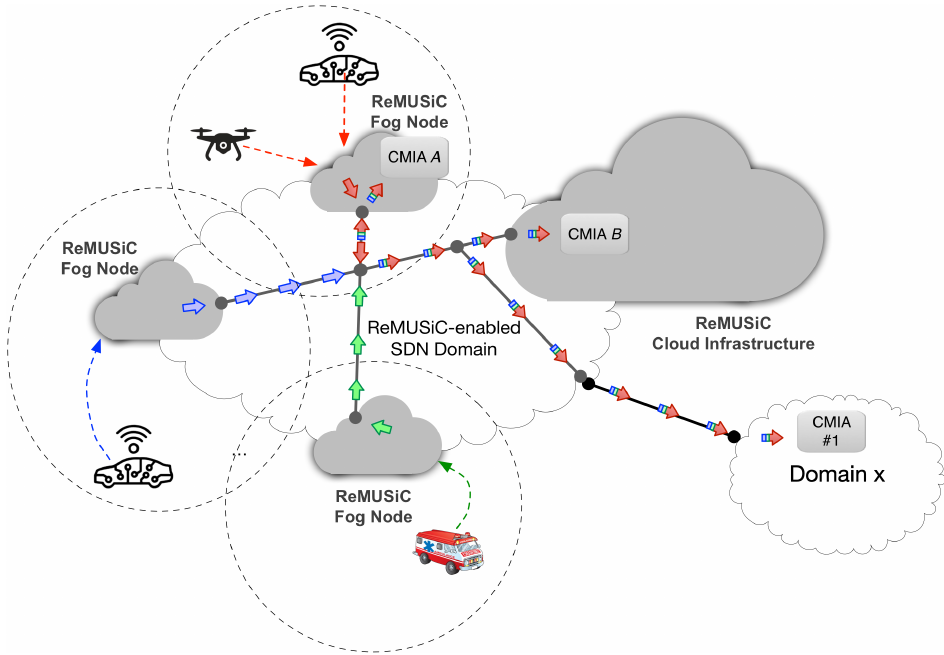
Figure 1. High-level of the Resilient MultiUser Session Control (ReMUSiC)-enabled